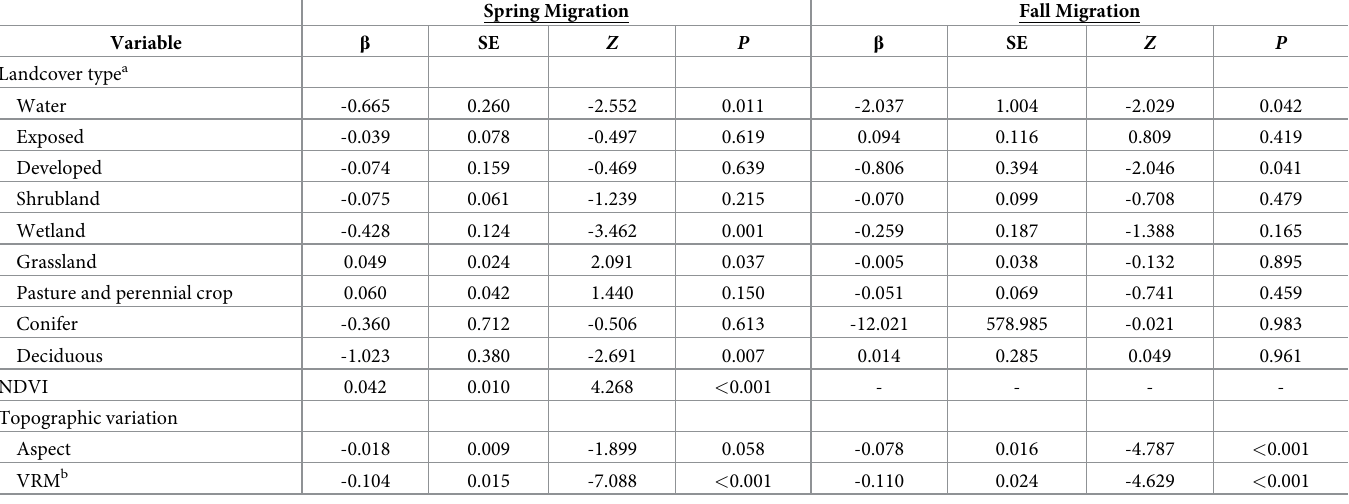
Table 3. Top third-order step selection function conditional logistic regression model coefficients for pronghorn migratory pathway selection during spring and fall migration across the Northern Sagebrush Steppe,